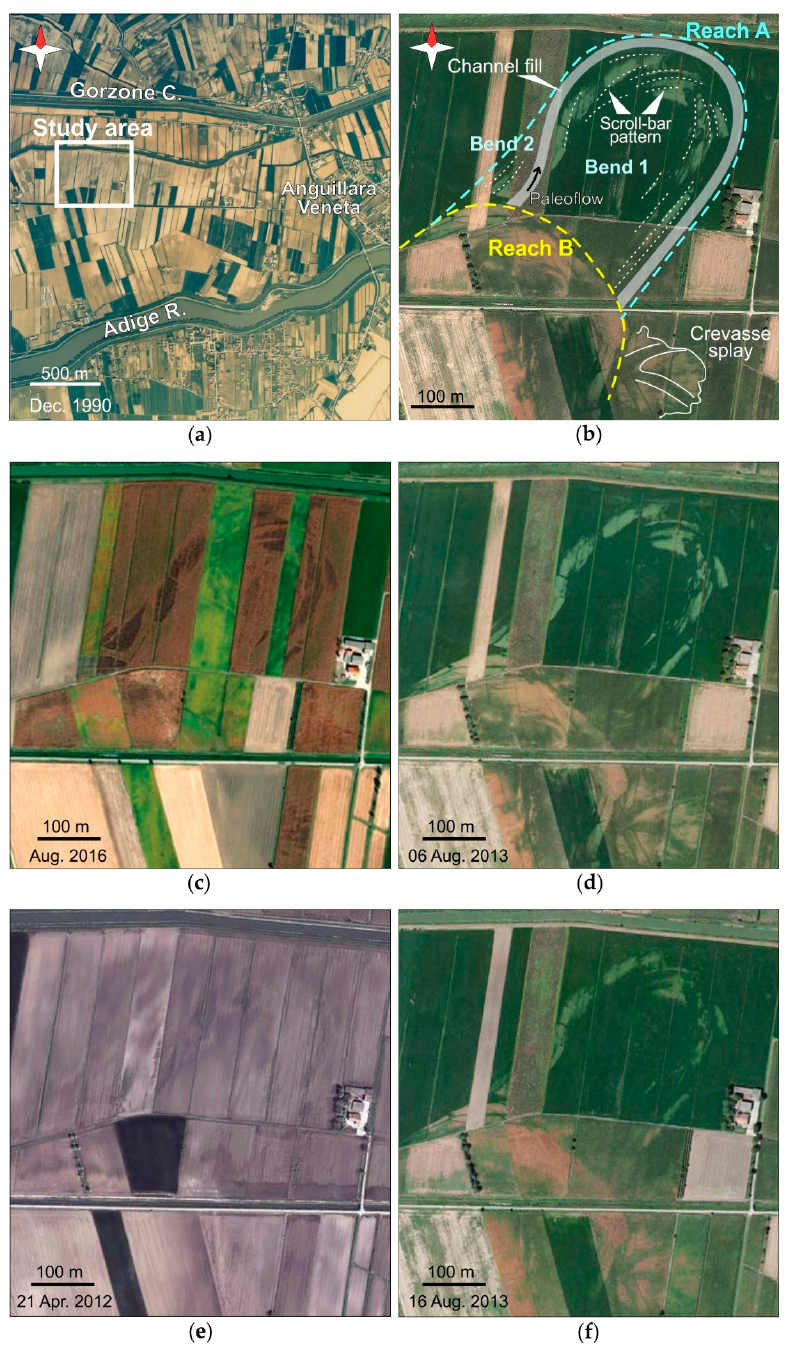
Figure 4. Remote-sensing results: ( a ) aerial photogram of the study area enhancing the poorly visible fluvial pattern during winter time; ( b ) meander belt reconstruction and fluvial morphology identification in the study area—white dashed lines highlight evidence of scroll-bar morphologies; and ( c – f ) satellite images (2016, 2013, 2012) providing information about fluvial morphology on the basis of seasons and soil